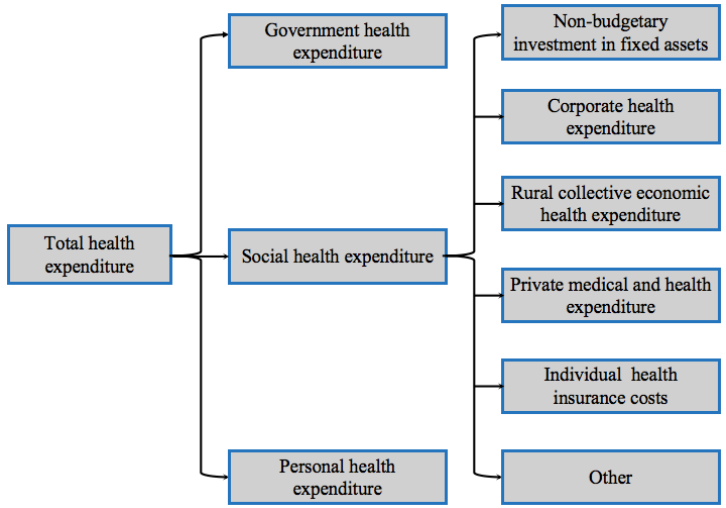
Figure 1. Method of dividing China’s national health accounts.